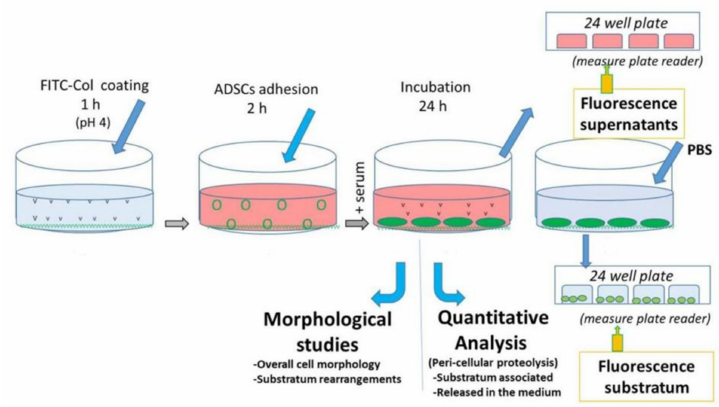
Figure 1. Schematic overview of FITC-Col I remodeling